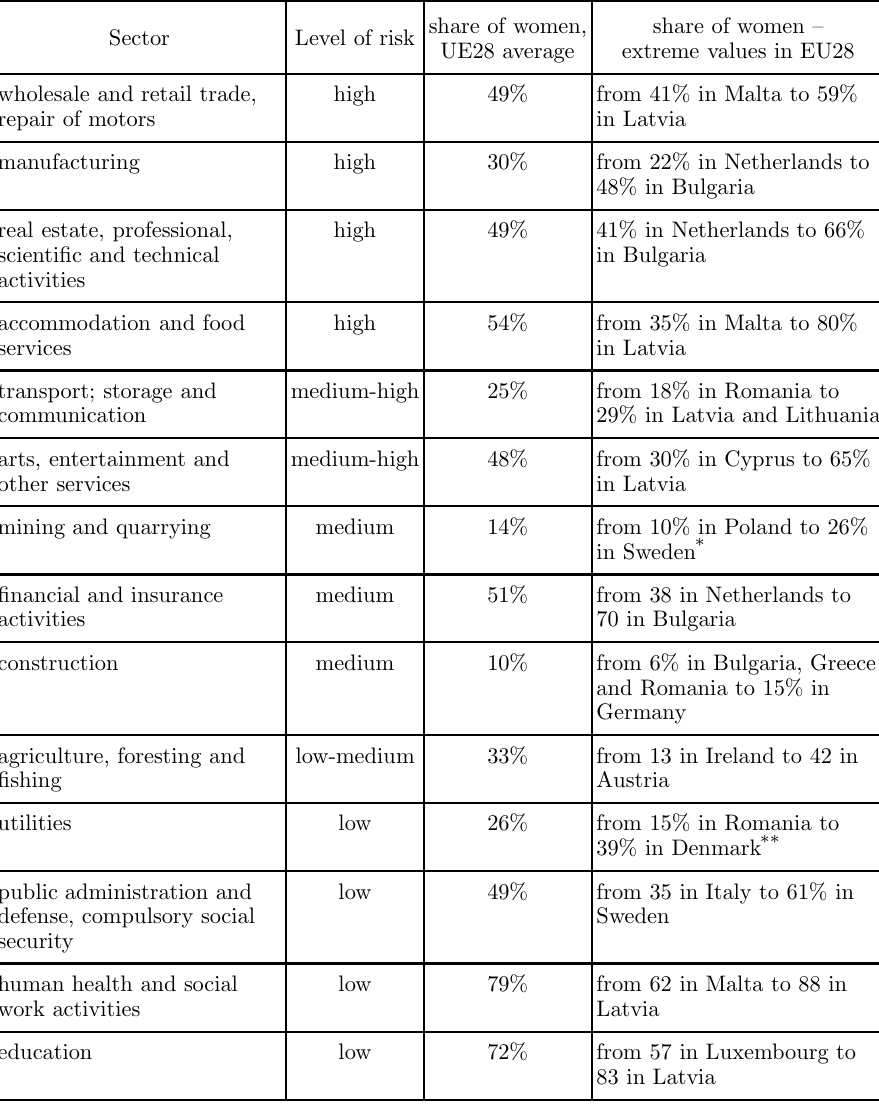
Women workers at risk – sectoral